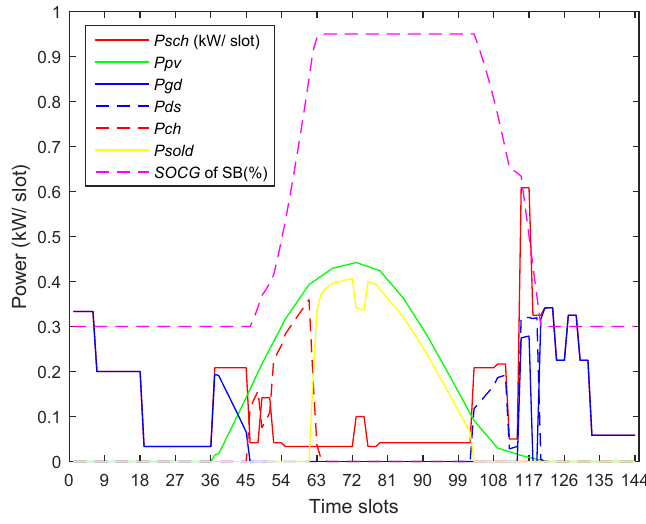
Figure 27. Load profile for minimal TBD using 3S-ToUP (Non-shifted) for PDDR-RED-based HEMS.